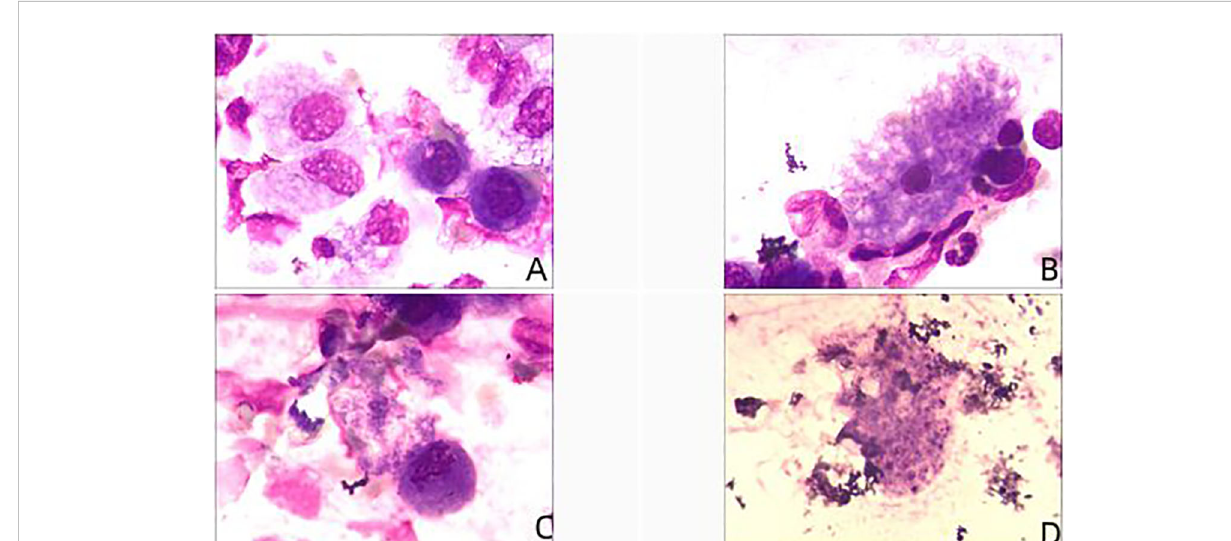
FIGURE 3 Regie ’ s stain results of case 1 (A, B) and case 4 (C, D) .